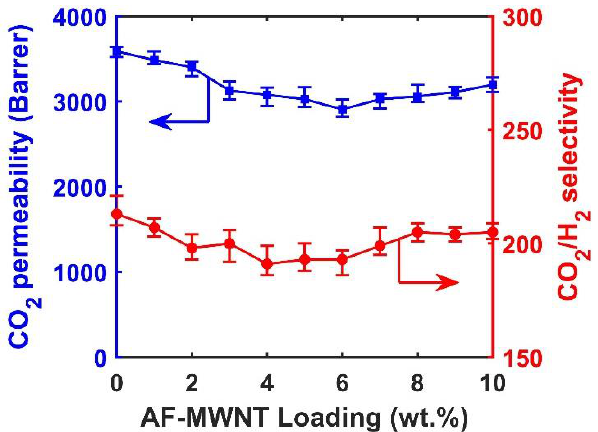
Figure 5. Effects of AF-MWNT loading on CO 2 permeability and CO 2 /H 2 selectivity under 0.2-MPa Figure 5. E ff ects of AF-MWNT loading on CO 2 permeability and CO 2 / H 2 selectivity under 0.2-MPa feed pressure: CO 2 permeability (  ) and CO 2 /H 2 selectivity ( ● ). Error bars represent the minimum and feed pressure: CO 2 permeability ( (cid:4) ) and CO 2 / H 2 selectivity ( • ). Error bars represent the minimum and maximum values of three samples. maximum values of three